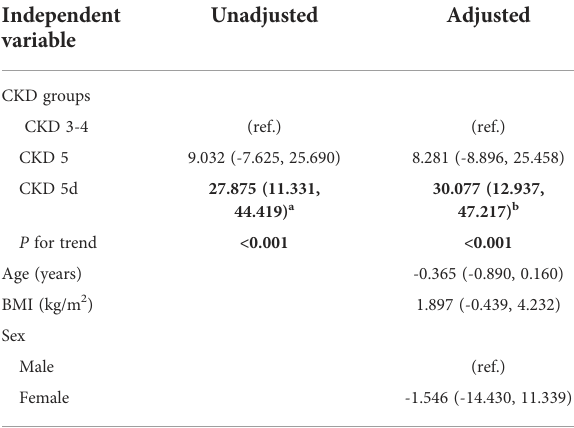
TABLE 4 Association of CKD groups with R2* (s -1 ) in unadjusted and adjusted models.